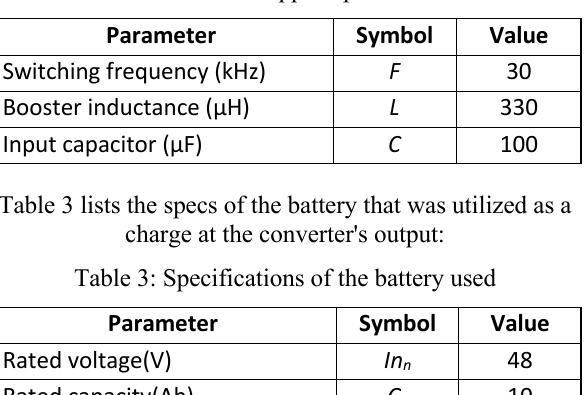
Table 2: Lift Chopper Specifications